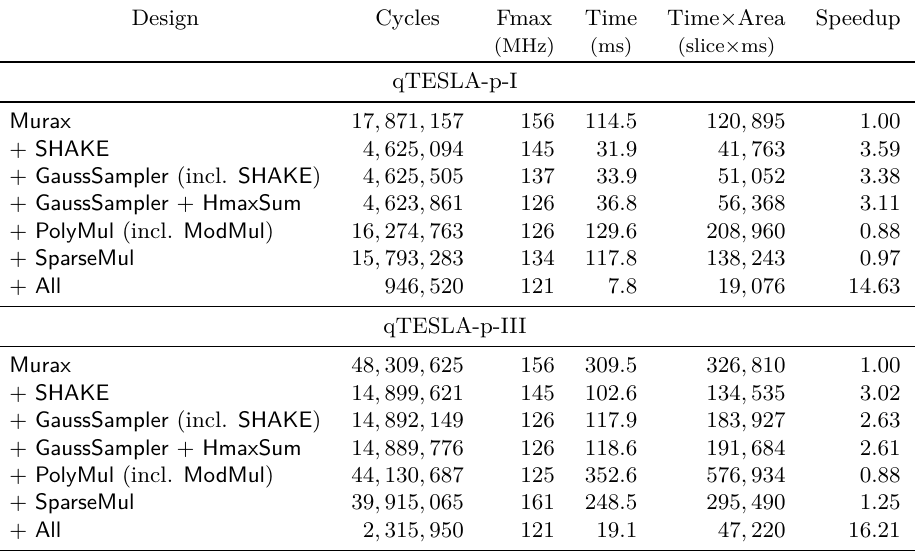
Table 11: Performance of qTESLA signature verification on software and different HW-SW co-designs. All = GaussSampler + HmaxSum + PolyMul + SparseMul . The “Speedup” column is provided in terms of